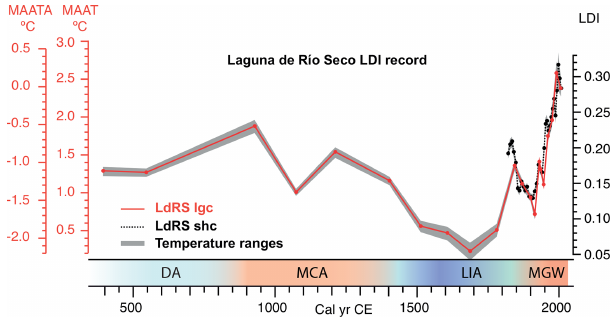
Figure 3. LDI record from LdRS, including both long core (solid line) and short core (dashed line), mean annual air temperature (MAAT, ◦ C) reconstruction from LDI records of LdRS, and mean annual air temperature anomaly reconstruction (MAATA, ◦ C) with respect to the annual MAAT of the last 30 years (1979–2008). The gray shading shows the reconstructed maximum and minimum tem- perature ranges obtained from the four LDI individual